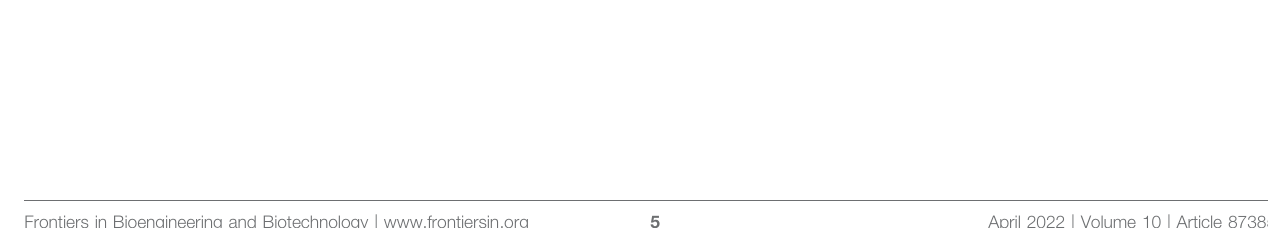
Frontiers in Bioengineering and Biotechnology |